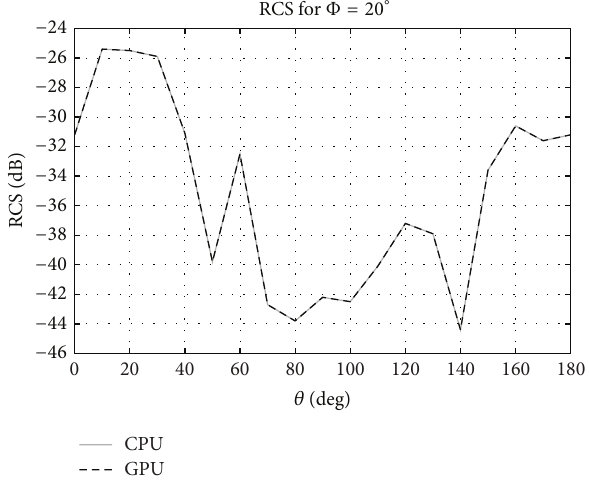
Figure 7: Comparison of speedup for the MoM matrix for fixed and variable number of integration